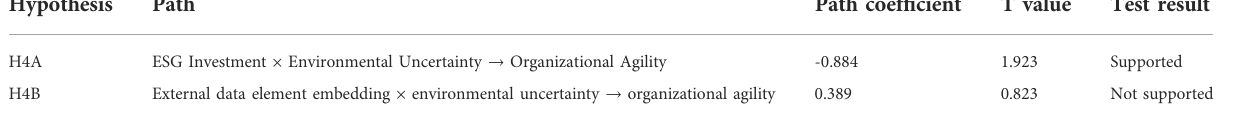
TABLE 5 Moderating effect test of environmental uncertainty.